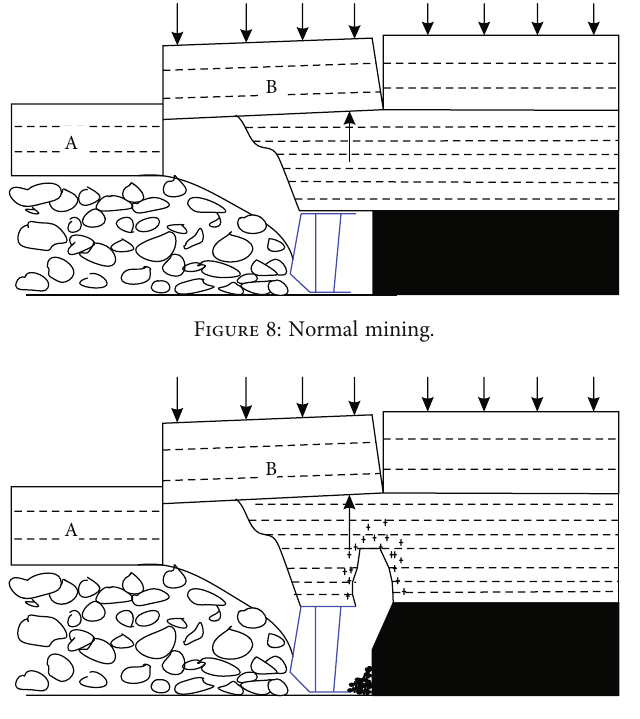
Figure 9: Roof caving caused by coal wall